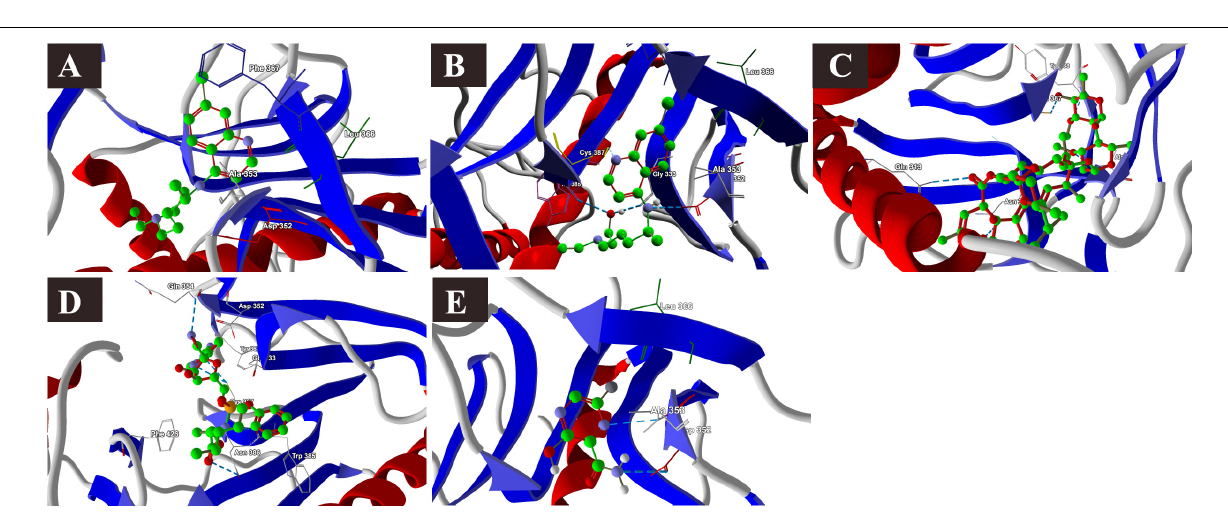
FIGURE 3 | Binding interactions of selected drugs with SARS-CoV-2 NSP14. (A) chloroquine, (B) hydroxychloroquine, (C) ivermectin, (D) remdesivir, and (E)